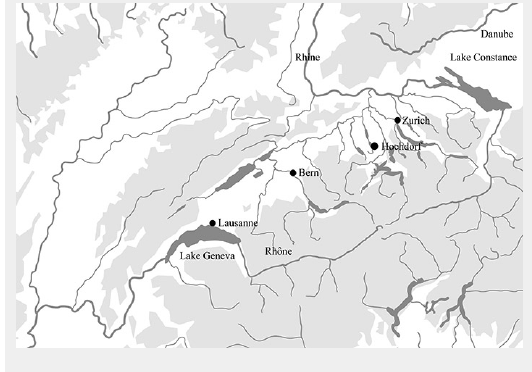
Location of Hochdorf, Canton Lucerne in Switzerland.